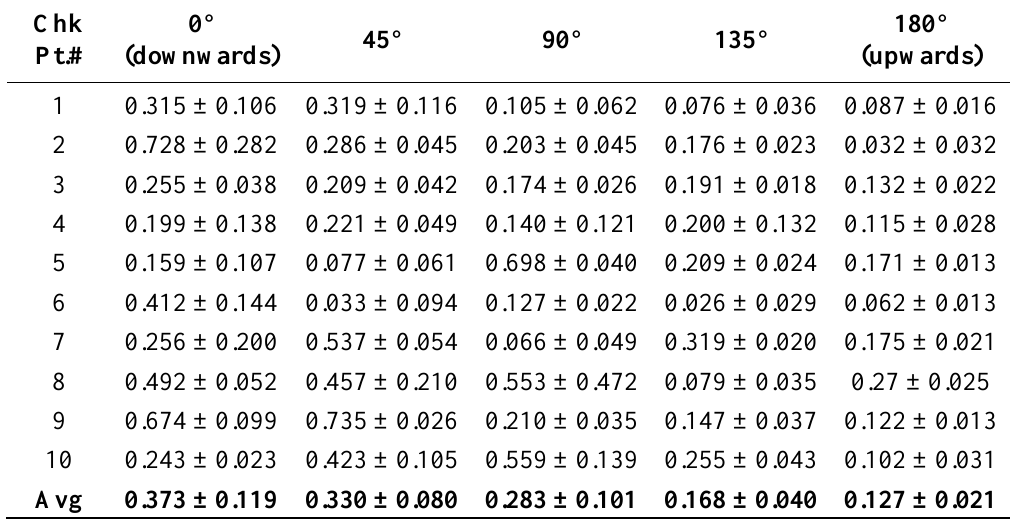
Table 3. Difference between MPV and true position ± standard deviation for different tilt angles. First column contains the check point number. Columns 2–6 contain error and standard deviation for each angle at which the phone was held. The bottom row shows average of all 10 check points.